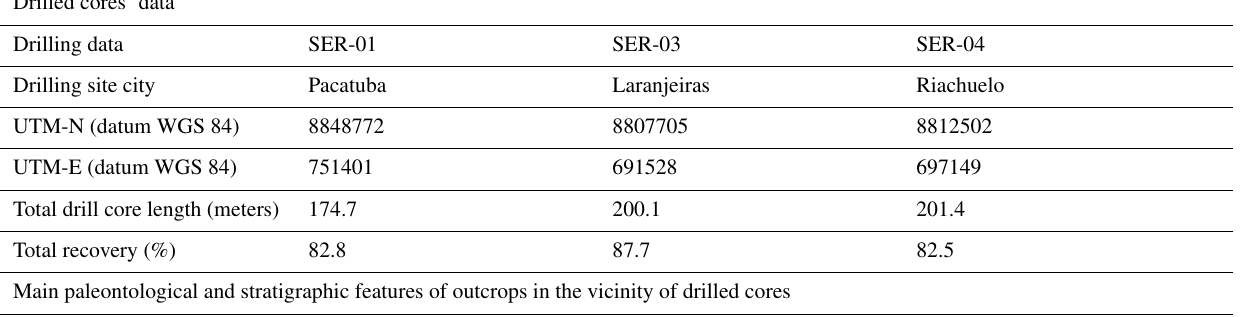
Table 1. Overview of the cores obtained from the Riachuelo Formation and Sergipe–Alagoas Basin as well as a summary of the main paleontological and stratigraphic features of outcrops in the vicinity of drill sites in the Riachuelo Formation and Sergipe–Alagoas Basin. Information adapted from Koutsoukos (1989) and Siqueira